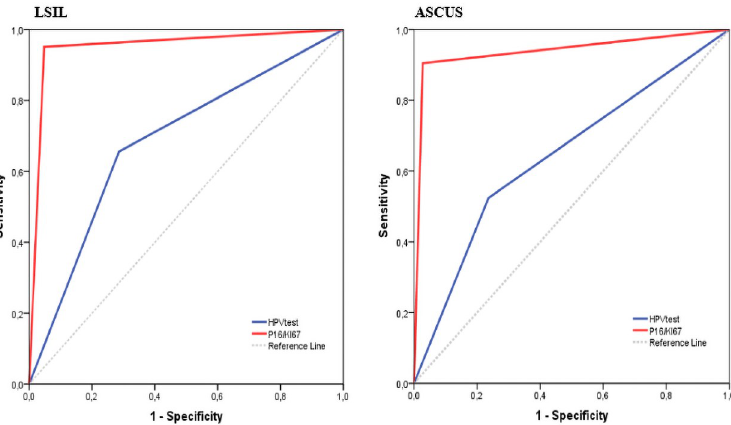
Fig 6. Evaluation of the two methods, HR-HPV test and p16/ki-67 by ROC curve analysis.